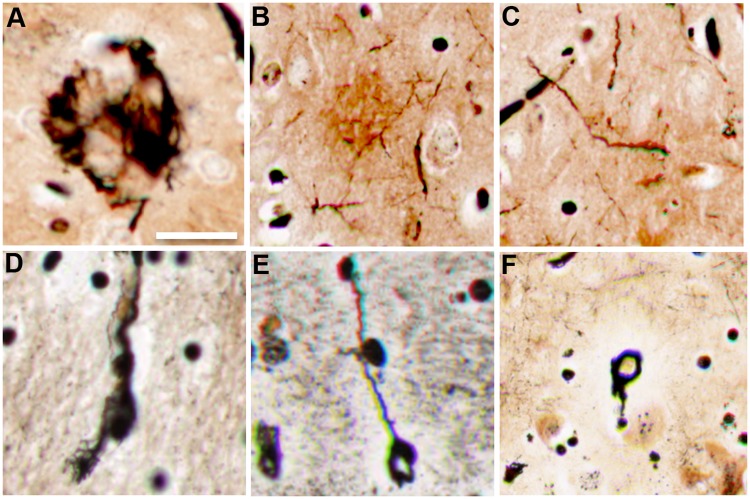
Neurodegenerative changes observed in the brains of stranded dolphins.(A) MB silver staining illustrates AD-like compact neuritic plaque in the ACtx of a stranded dolphin. (B) A representative digital scan of an ill-defined agrophyllic plaque containing dystrophic neurites. (C) Dense neuropil threads were observed in the VCtx. (D, E) agrophyllic neurons containing dystrophic neurites. (F) Coiled body in the ACtx. Representative scale bars: 50 μm.